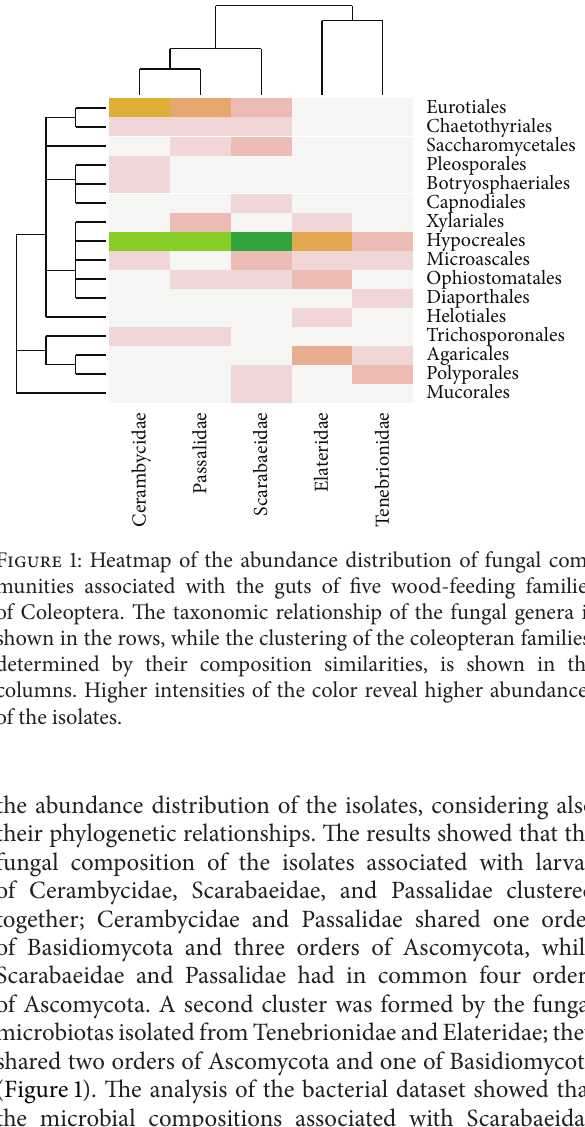
Table 5: Results of the screening for lignocellulolytic activities. Fungal genera with positive results are shown in the upper group and bacterial genera in the lower group.